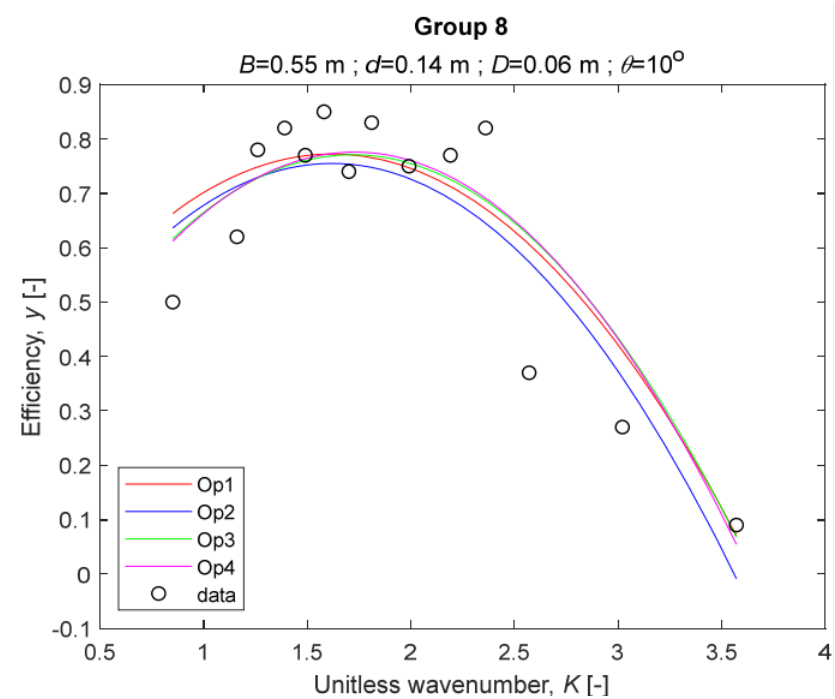
Figure 10. The four models for Group